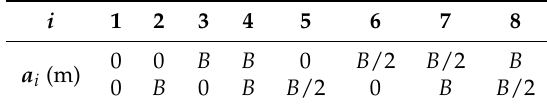
Table 1. True locations of anchors in the simulation